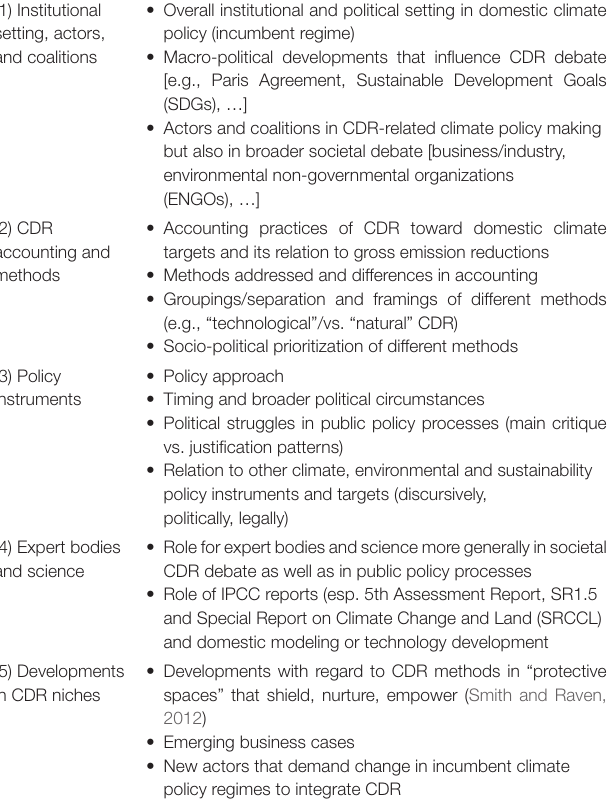
TABLE 1 | Dimensions of